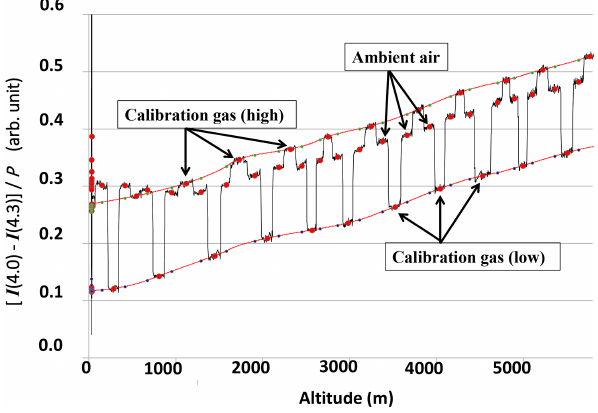
Figure 3. Raw data obtained by the CO 2 sonde launched on 26 September 2011 at Moriya, Japan. The vertical axis is the dif- ference between the 4.0 and 4.3µm signal intensities divided by the ambient pressure. The black line indicates the observation results during the balloon flight with calibration cycles. The red circle in- dicates the 30s average values in each step of the calibration. The red curve indicates the cubic spline fitting curves for the observa- tion points of the 30s average values of the same standard gas. The small black dots on the cubic spline curves indicate the estimated values for the standard gases at the ambient gas measuring timing, which is used for the interpolation to determine the ambient air con-